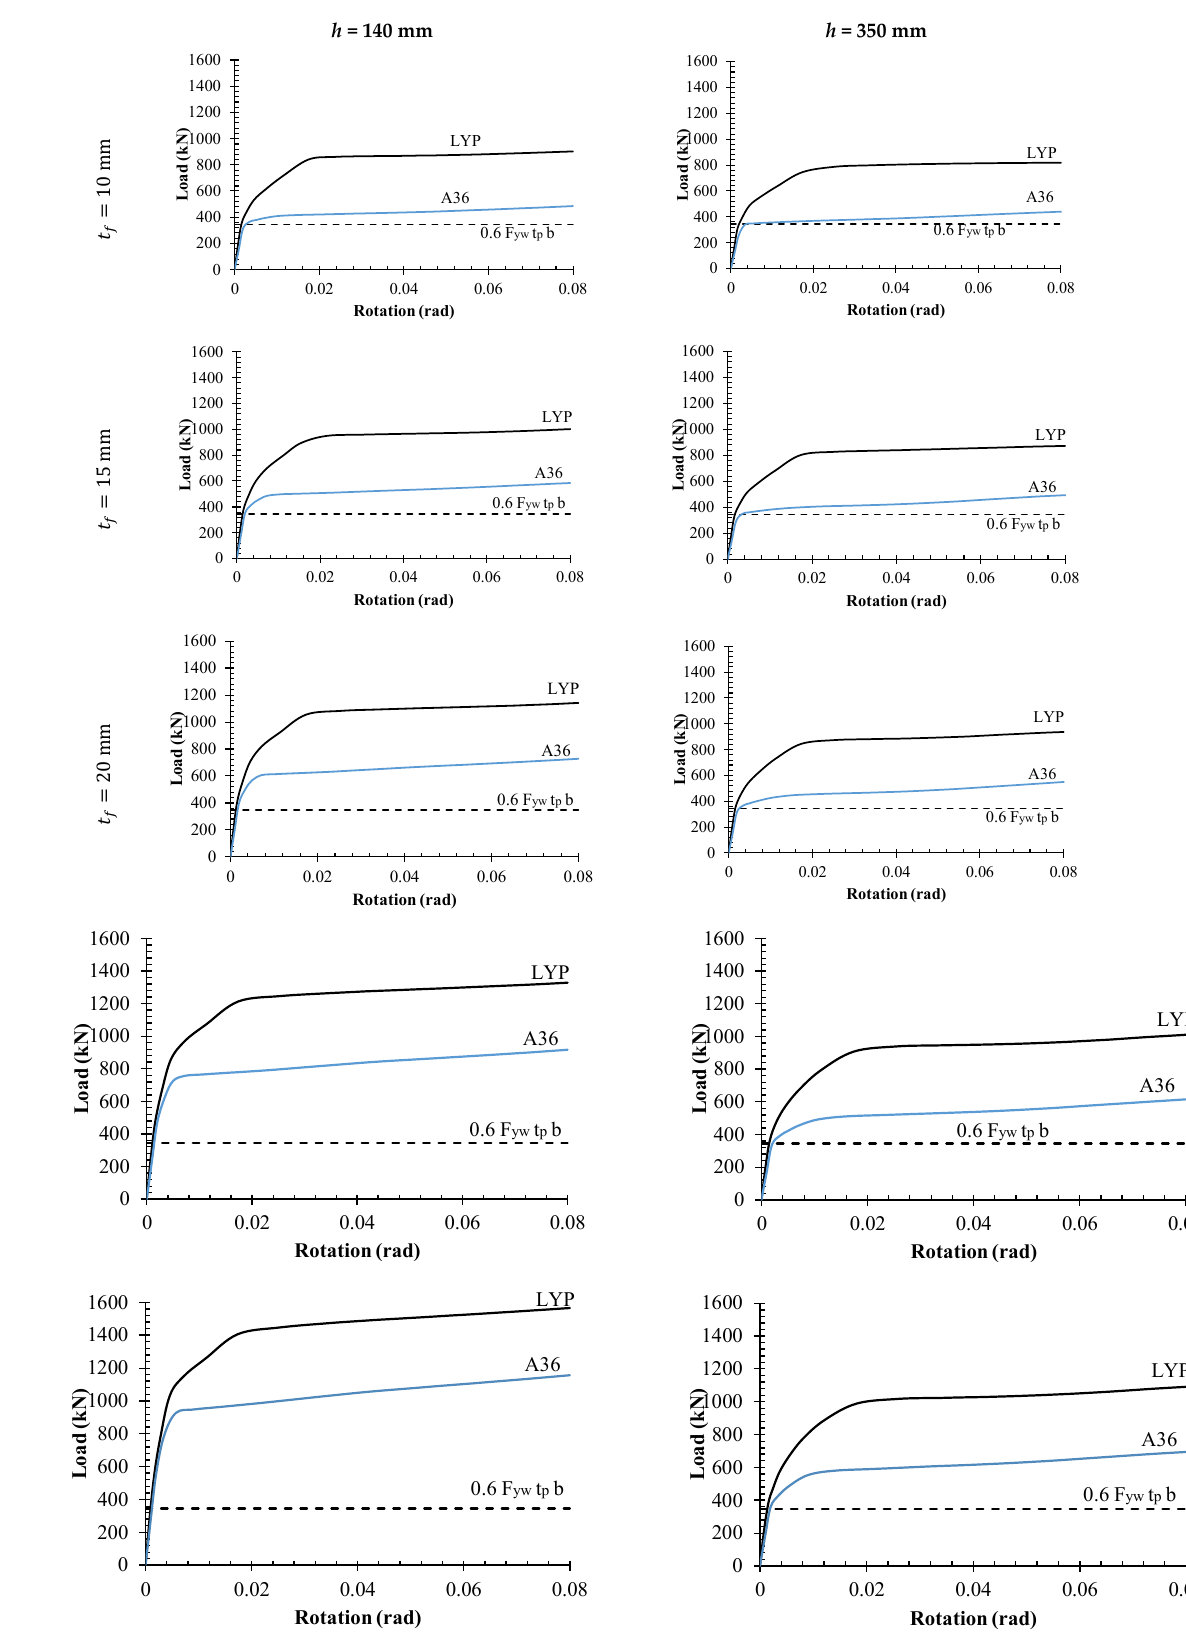
Figure 7. Comparing the load-rotation of damper with LYP and A36 steel for h = 140 mm and h = 350 mm. Table 3. The structural parameters.